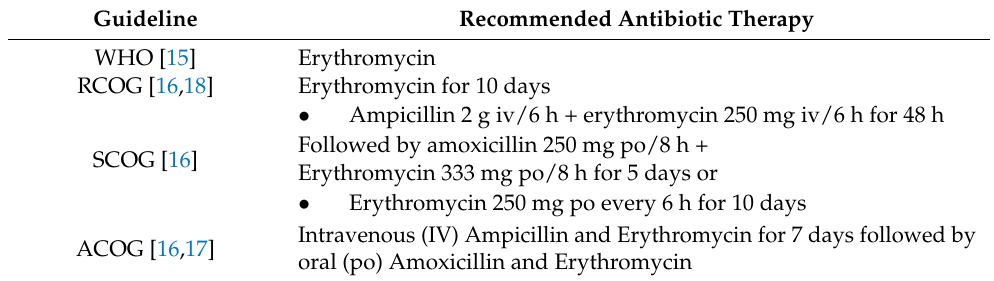
Table 5. The main recommendations of the guidelines regarding antibiotic